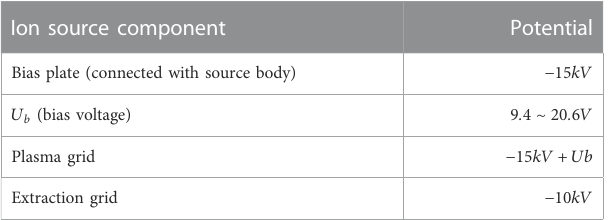
TABLE 1 Potential parameters of source components